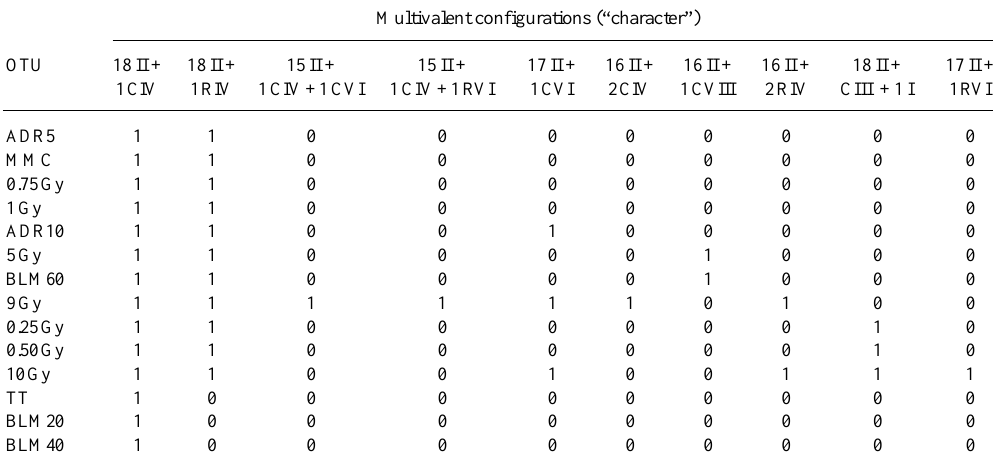
Table III - Basic matrix data employed for the multivariate analysis (BMD). Multivalent configurations